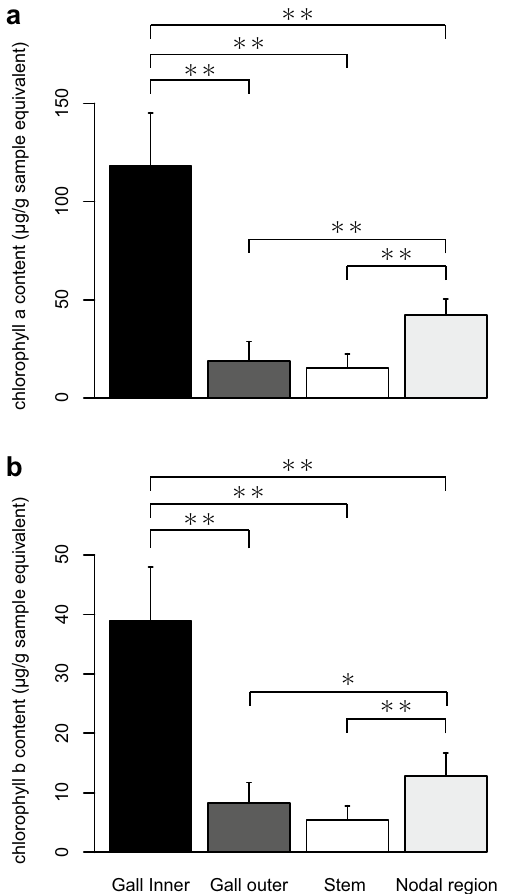
Figure 5. Chlorophyll content in Cuscuta campestris . ( a ) Chlolrophyll a and ( b ) chlorophyll b contents. The values are shown as means ± SD. Asterisk indicates statistically significant difference (*P < 0.05; **P < 0.01; Wilcoxon rank sum test with Bonferroni